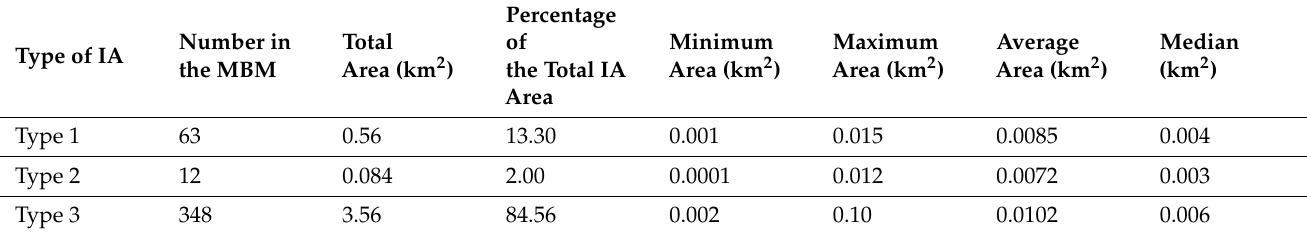
Table 4. Type-wise distribution of IAs in the MBM.